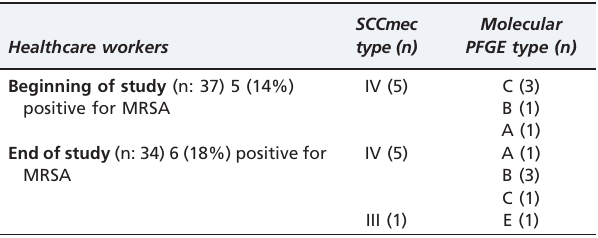
Table 4 - The SCC mec and molecular types of 11 MRSA isolates obtained from healthcare workers at the beginning and the end of the